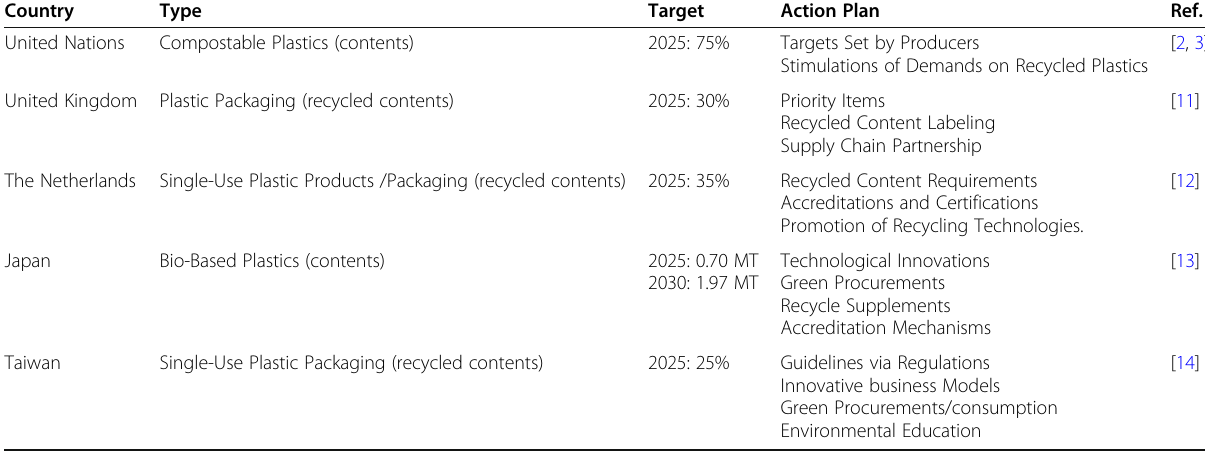
Table 1 International efforts on increasing the recycled contents in plastic products